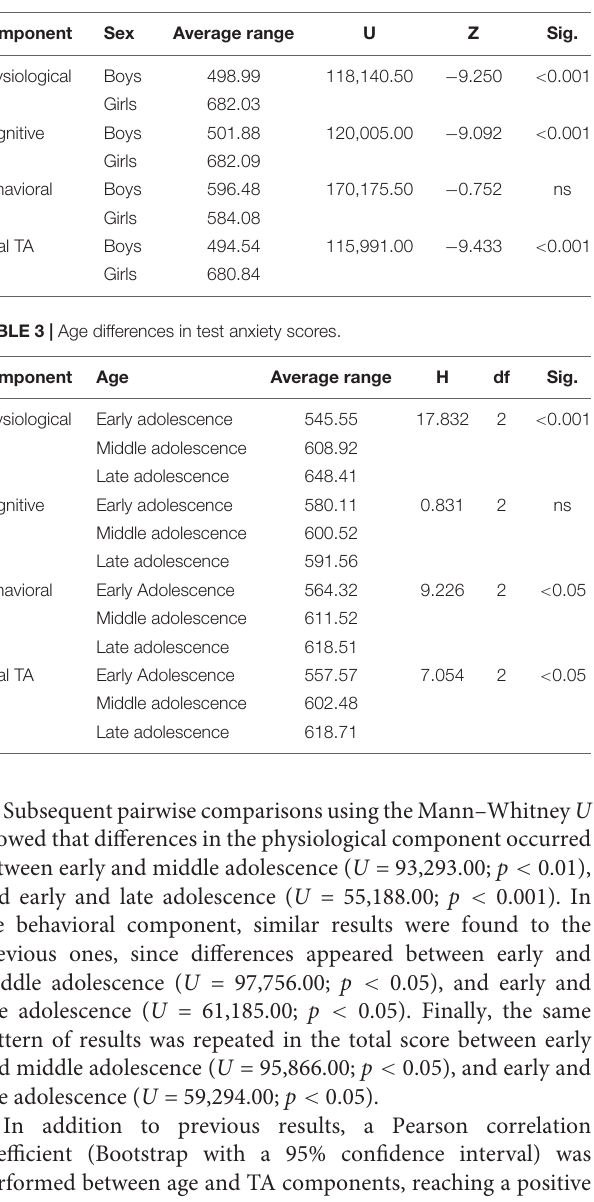
TABLE 4 | Difference between educational levels in test anxiety.